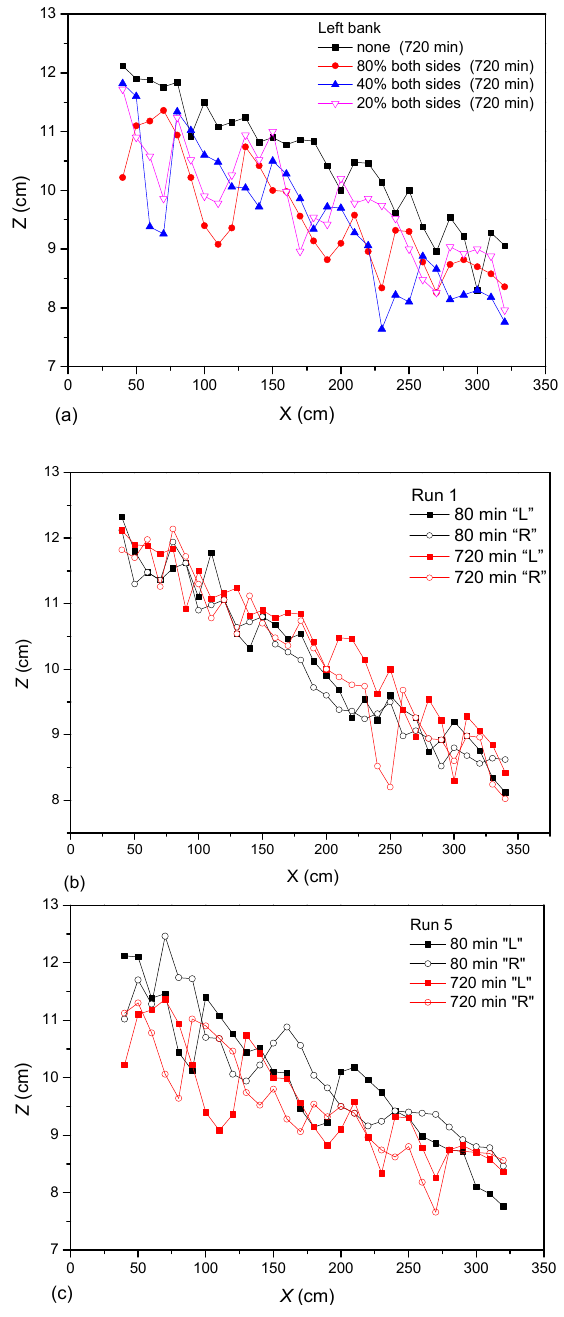
Figure 14. Longitudinal variation of near-bank bed elevation ( a ) for different riparian vegetation cover, ( b ) no riparian vegetation coverage in Run 1 and ( c ) 80% riparian vegetation coverage in Run 5, where L represents left bank and R represents right bank in the figure legend.